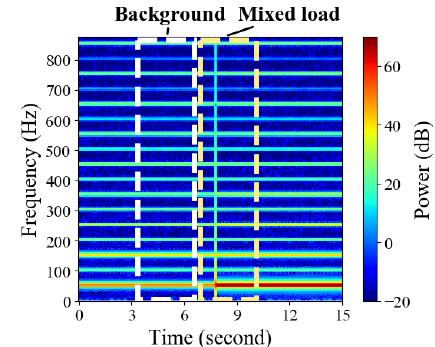
Figure 3. The background load part and the mixed load part of a complete